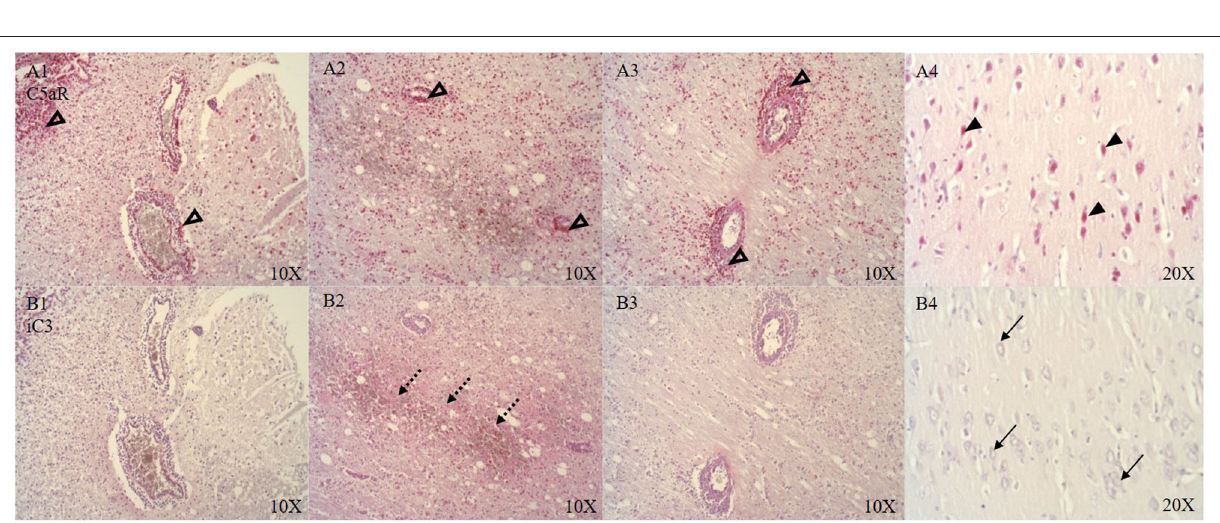
FIGURE 5 | C5aR ( A , n = 8) and iC3 ( B , n = 7) expression around the ASDH site in four anatomical levels of the parietal cortex (A/B 1–3) and distant to the ASDH site (A/B 4). Around the ASDH site perivascular infiltration of C5aR positive immune cells (unfilled arrow heads A1–3 ), immune cell and parenchymal localization of iC3 (punctuated arrows B1–3 ), distant to the ASDH site nuclear expression of C5aR in cortical neurons (black arrow heads A4 ), no neuronal iC3 detection distant to the ASDH site (black arrows B4 ). C5aR, complement component 5a receptor; iC3, induced complement component 3; ASDH, acute subdural hematoma.